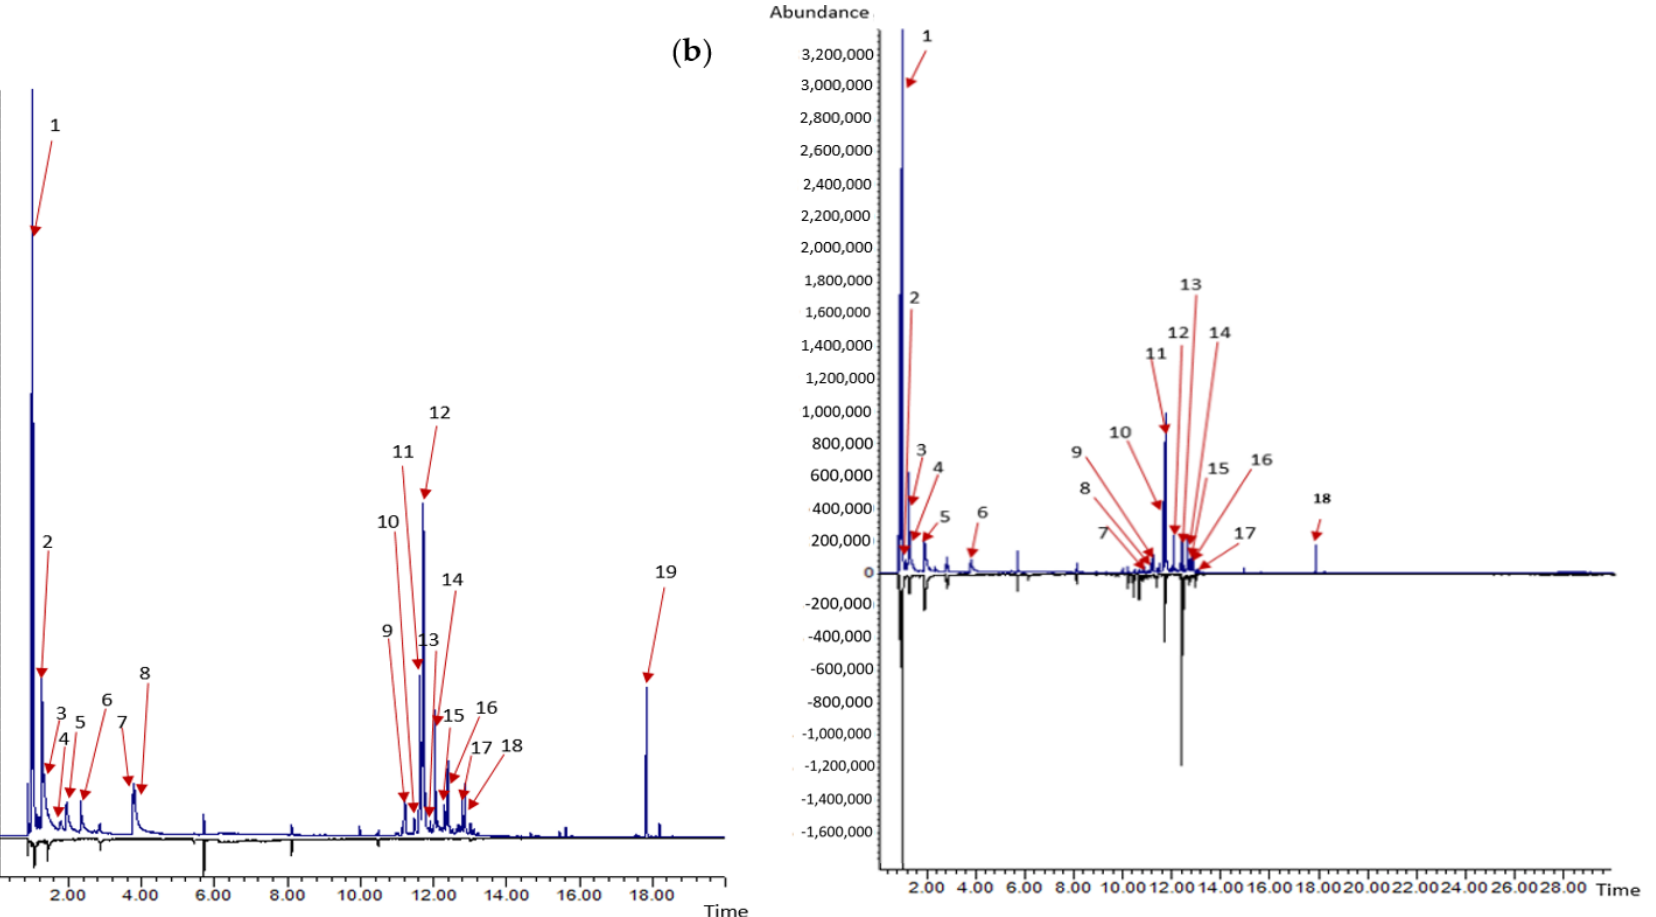
Figure 5. Overlay plot of ( a ) pure culture of strain #5029 on top and media control at bottom; ( b ) co − culture of strain #5029 with P. noxium on top and pure culture of P. noxium strain at bottom. Numbers refer to compounds listed in Table 2.